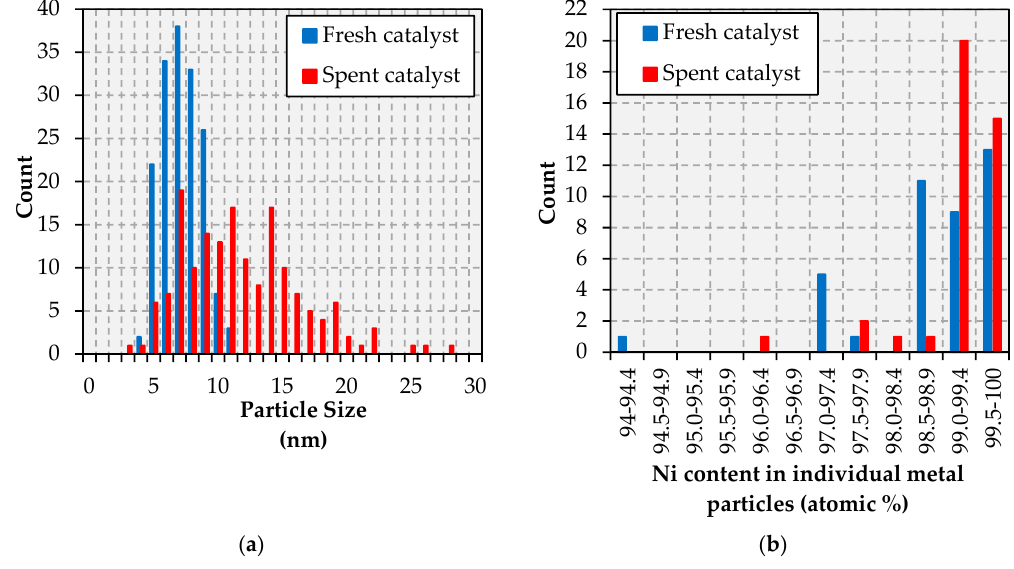
Figure 8. Particle size distribution ( a ) and metallic composition ( b ) histograms for the Ni-Pt catalyst.